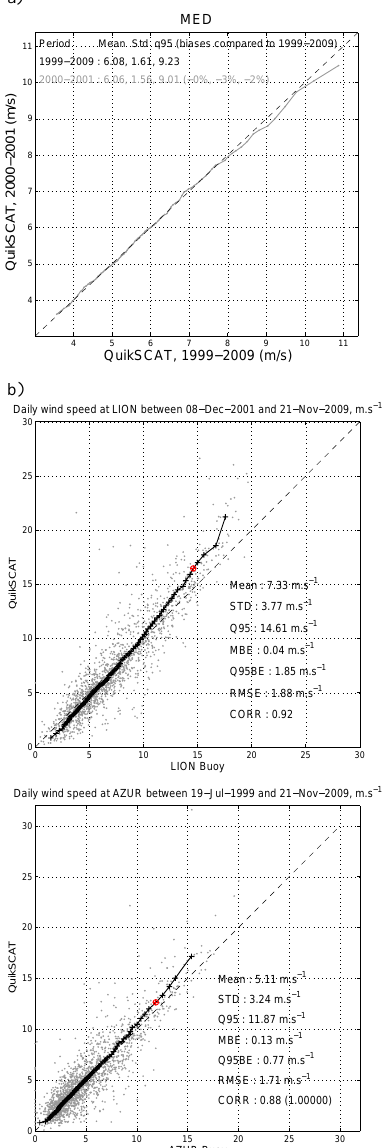
Fig. 2. Representativeness of daily wind variability by QuikSCAT. (a) Q - Q plot of QuikSCAT daily wind speed distribution between 1 January 2000 and 31 December 2001 compared to distribution between 19 July 1999 and 21 November 2009. (b) Scatterplot and Q - Q plot of QuikSCAT daily wind speed compared to average in- situ daily wind speed at buoys LION and AZUR over the periods during which satellite and in-situ data are both available. Values of the average, standard deviation and 95th percentile of the daily wind speed at the buoys are indicated, as well as the mean bias (MBE), the 95th percentile bias (Q95BE), the RMSE and the cor- relation of QuikSCAT daily wind speed compared to the buoy daily wind speed. Red circles indicate the value of the 95th percentile. Unit: ms − 1